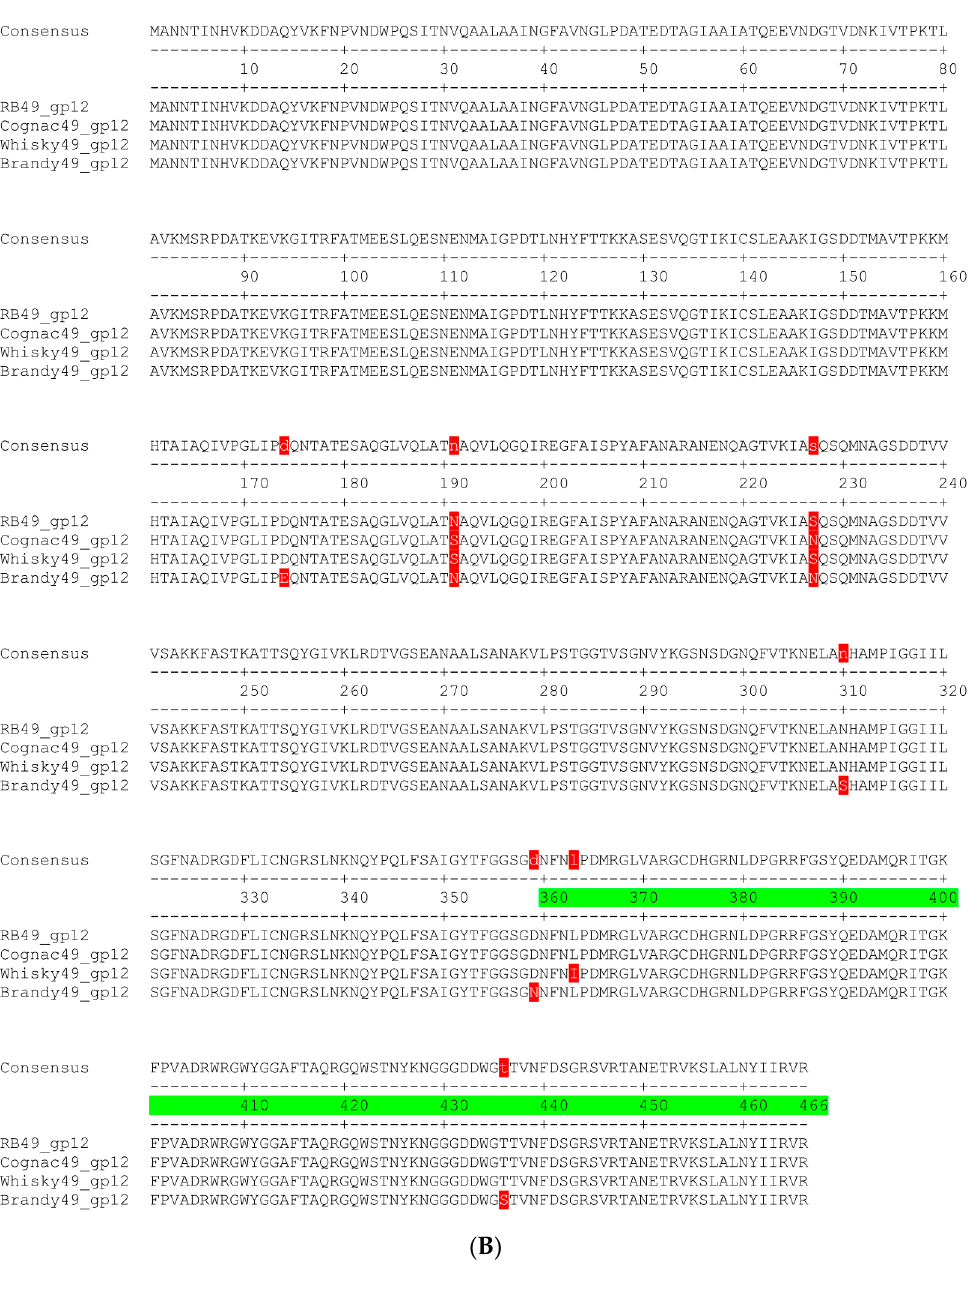
Figure 1. Comparison of the receptor-recognition proteins sequences. Mismatches in the sequence colored red. ( A ) The receptor-binding protein of the LTF gp38. The secondary structure elements of the C-terminal receptor binding domain are indicated above the consensus sequence in accordance with their numbering in [31]. ( B ) The short tail fiber protein gp12. Putative receptor-recognition domain colored green.